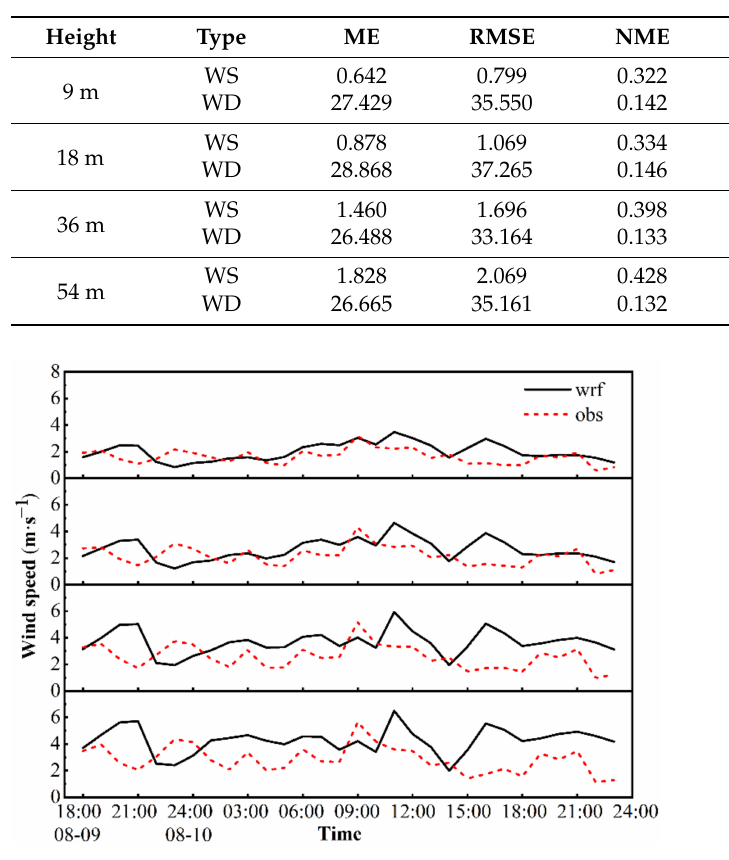
Table 1. Statistical evaluation of WRF simulation results.